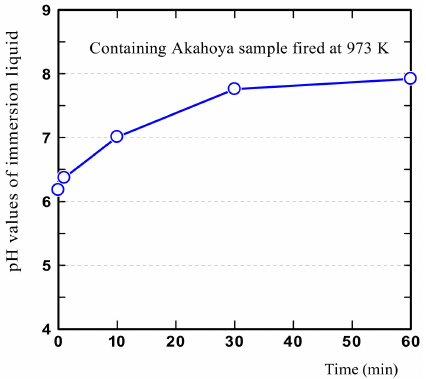
Figure 5. Liquid pH after Akahoya sample